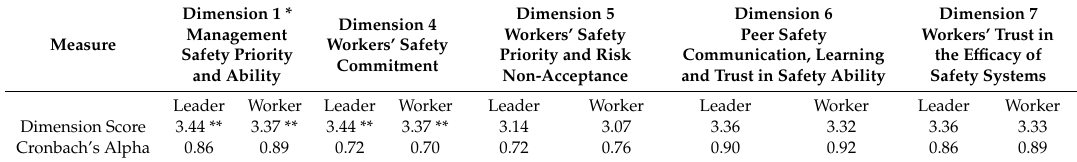
Table 2. Montana logging survey 2017: Safety climate survey results by dimension.